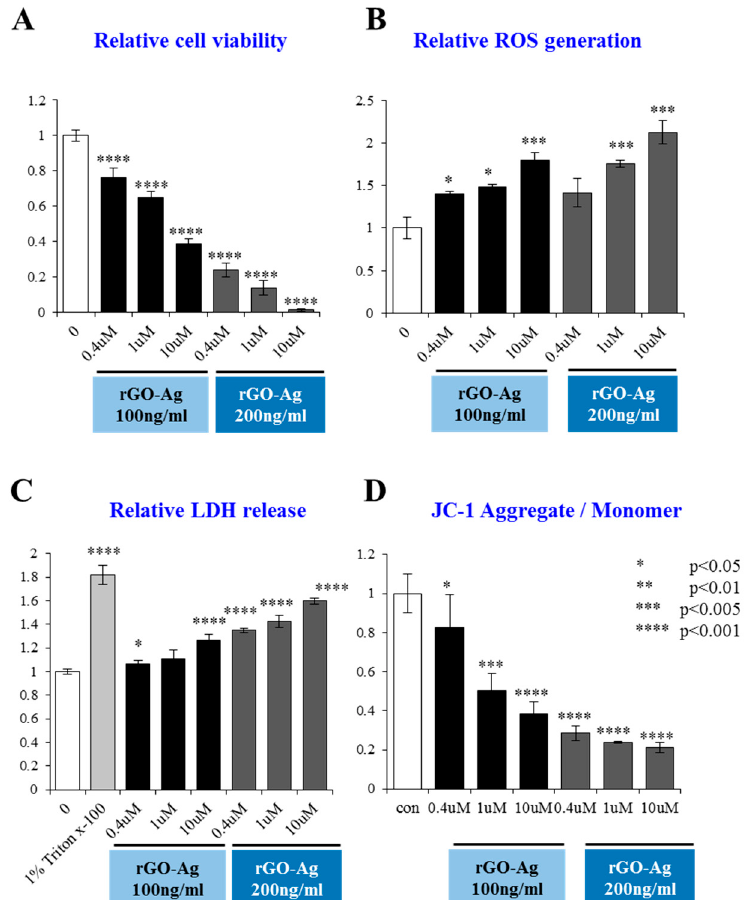
Figure 9. Effect of rGO–Ag, salinomycin and the combination of rGO–Ag and salinomycin on cytotoxicity. ALDH + CD133 + cells were treated with 100 ng/mL rGO–Ag plus 0.4, 1.0, and 10 µM of salinomycin and 200 ng/mL rGO–Ag plus 0.4, 1.0, and 10 µM of salinomycin for 24 h. Cell viability was determined using a cell counting kit (CCK-8) assay ( A ); reactive oxygen species (ROS) generation was determined by 2 ′ ,7 ′ -dichlorofluorescein diacetate (DCFDA) ( B ); lactate dehydrogenase (LDH) activity was measured at 490 nm using the LDH cytotoxicity kit ( C ); mitochondrial transmembrane potential (MTP) was determined using the cationic fluorescent indicator JC-1 ( D ). The results are expressed as the mean ± standard deviation of three independent experiments. The treated groups showed statistically significant differences from the control group according to Student’s t -test (* p < 0.05).